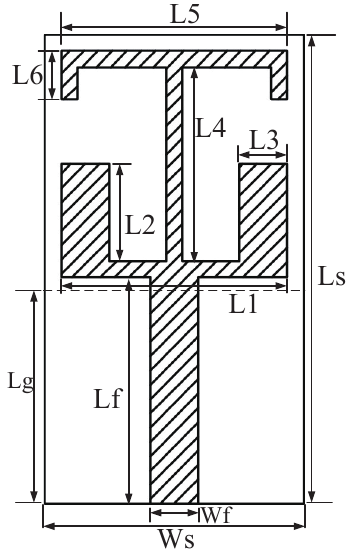
Figure 3. Antenna structure